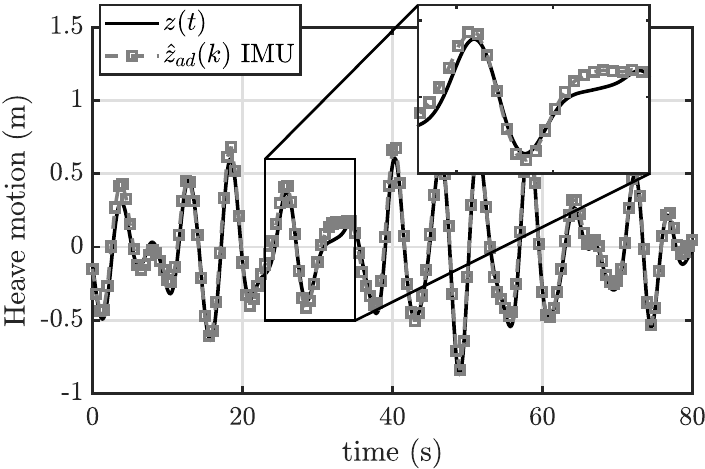
Figure 10. Heave motion compared with its estimation obtained with the IMU framework (Wave Id